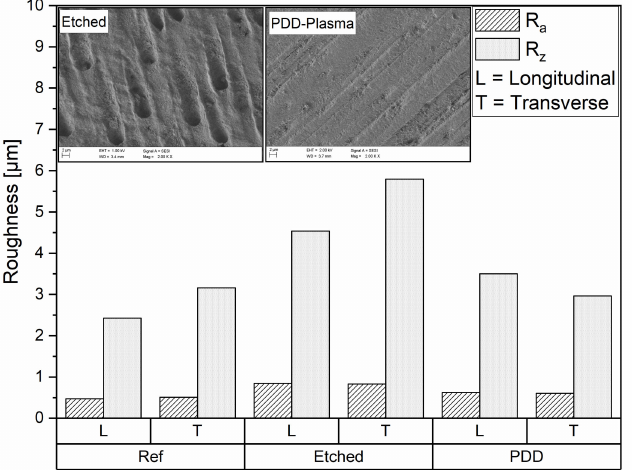
Figure 6. Longitudinal (L) and transverse (T) tactile measured surface roughness of dentin (Ref), of surfaces modified by acid etching (Etched), and of surfaces modified by atmospheric PDD plasma, with SEM images of the modified surfaces ( n =